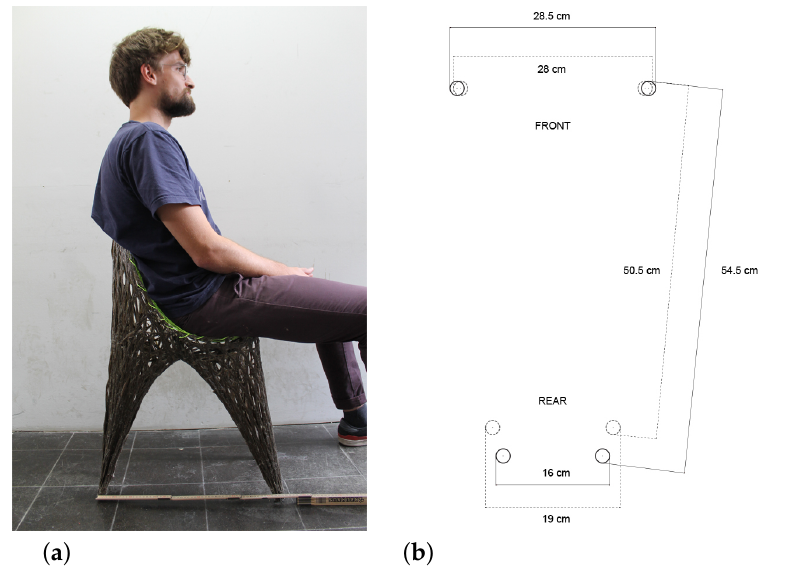
Figure 20. Non-destructive sitting test ( a ) Sitting test preview ( b ) Displacement diagram of chair feet: Dashed lines represent geometry under no load. Solid lines represent geometry under load.